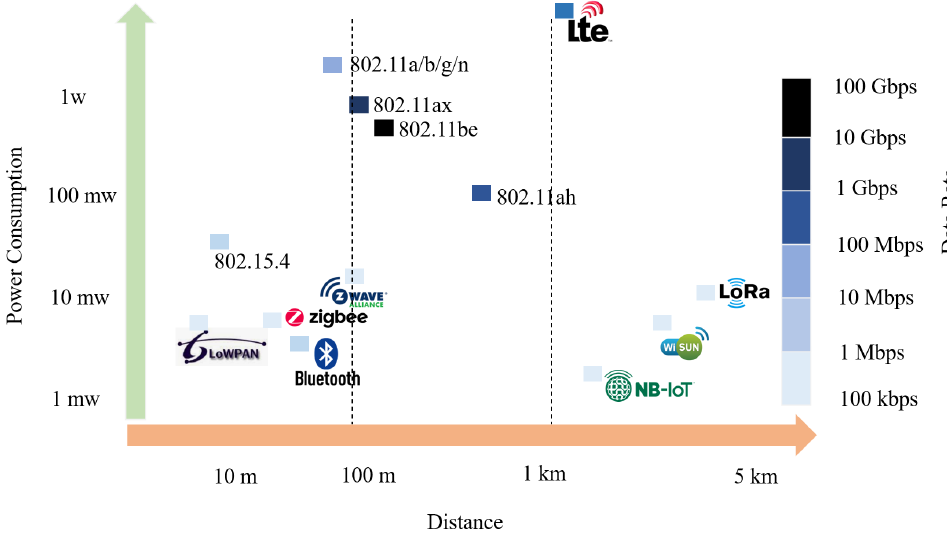
Figure 3. Power consumption, coverage distance, and data rate for the different